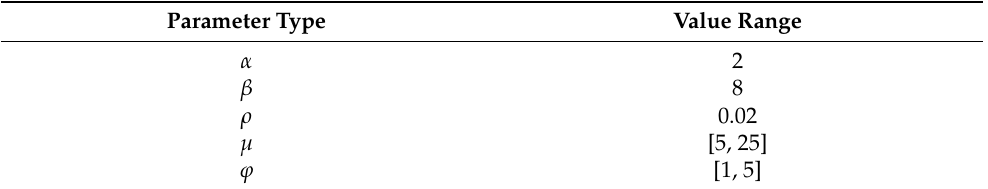
Table 1. Parameter